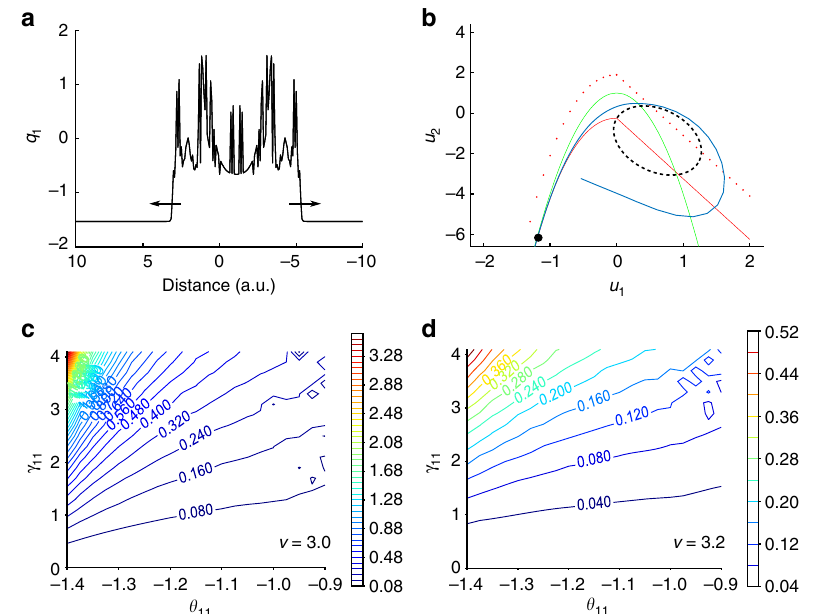
Fig. 3 Seizure propagation via slow-traveling ictal wavefront in the Epileptor fi eld model. a Plot of a traveling front solution in the fast population. b Phase space for the fast population variables ( u 1 and u 2 ). In the interictal state, the system is on the left stable fi xed point (black dot) at the crossing of the cubic- linear nullcline _ u 1 ¼ 0 (full red line) of Eq. 1 and the squared nullcline _ u 2 ¼ 0 (green line) of Eq. 2 (Methods). After seizure onset, excitation through local coupling moves the red nullcline of neighboring Epileptors upward (dashed red line) until disappearance of the left stable fi xed point, resulting in the activity (blue line) to jump to the stable limit cycle (black dashed line). c Speed of propagation (a.u.) of the ictal wavefront as a function of the activation threshold θ 11 and the connection strength γ 11 , with the permittivity variable set to v = 3.0. The speed of propagation is slow if the threshold of activation θ 11 is higher than the value of the fast population activity ( u 1 ) in the interictal state. d Same conventions as in c for a permittivity variable v = 3.2. The speed of propagation remains slow for other values of the permittivity